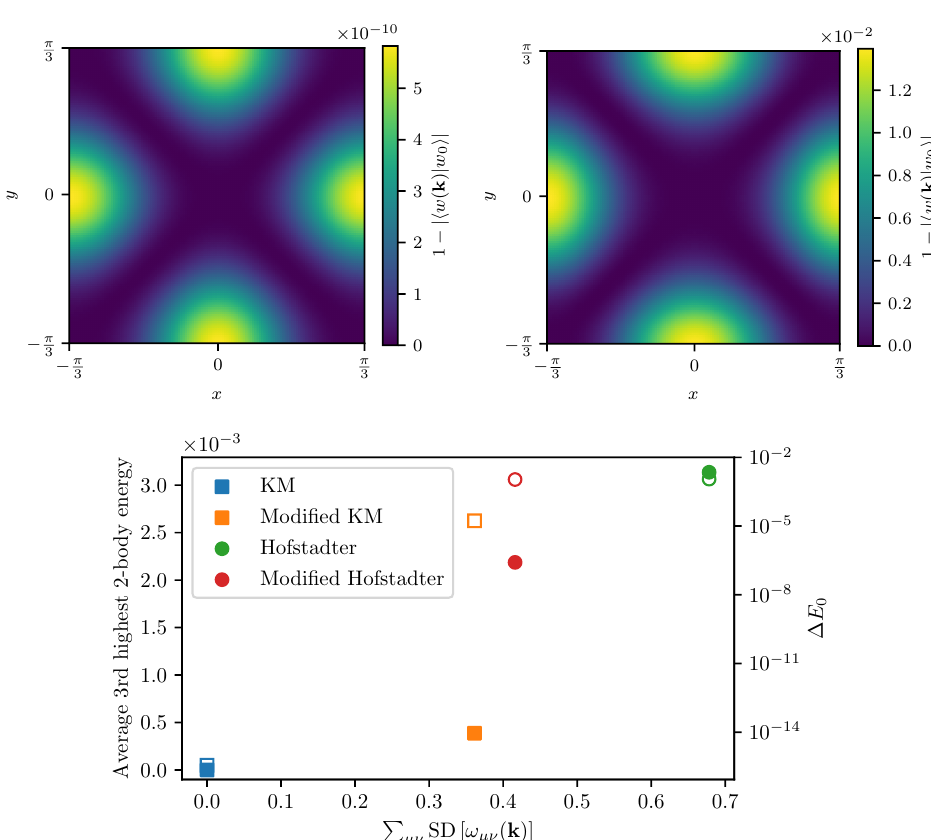
Figure 6: Above: Overlap of the null vector | ω ( k ) 〉 of the quantum geometric tensor with the exact null vector for the 3-band KM model (left), and optimized KM model with constant curvature (right). Note the scales of the colorbars. Below: Dependence of the average third highest 2-body energy (full symbols) and the average ground- state splitting (empty symbols) on the deviation from the ideal condition for the quantum